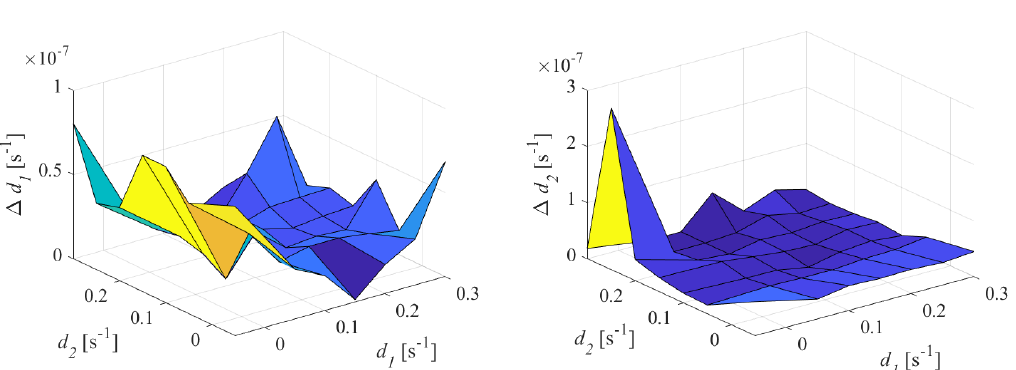
Figure 6. FoMs evolution versus damping coefficients obtained in numerical tests with ideal signal; results for frequency f 1 ( on the left ) and f 2 ( on the right ).